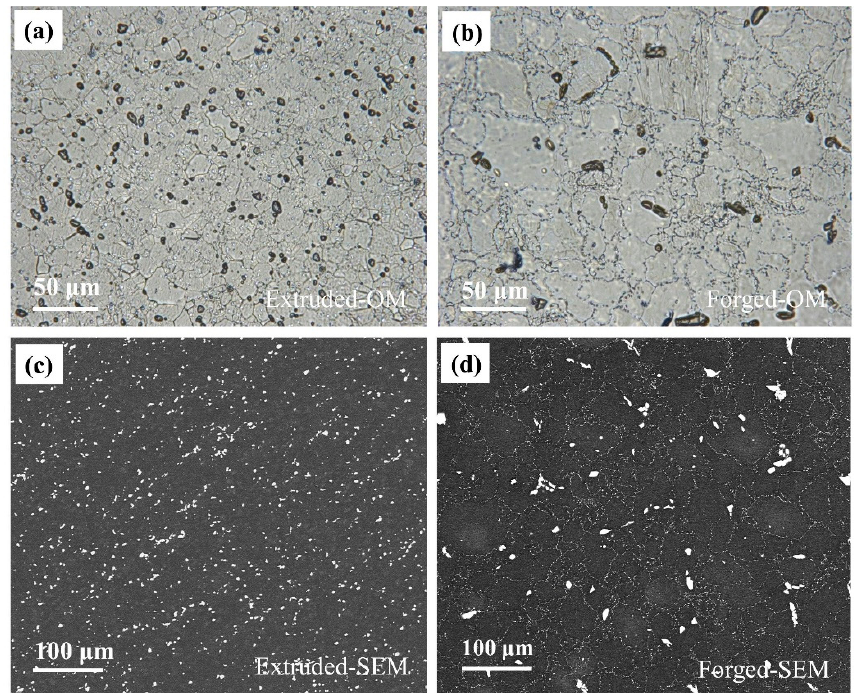
Figure 2. Optical microstructures and scanning electron microstructure of experimental WE43 alloys: ( a , c ) the extruded WE43 alloy; ( b , d ) the forged WE43 alloy.